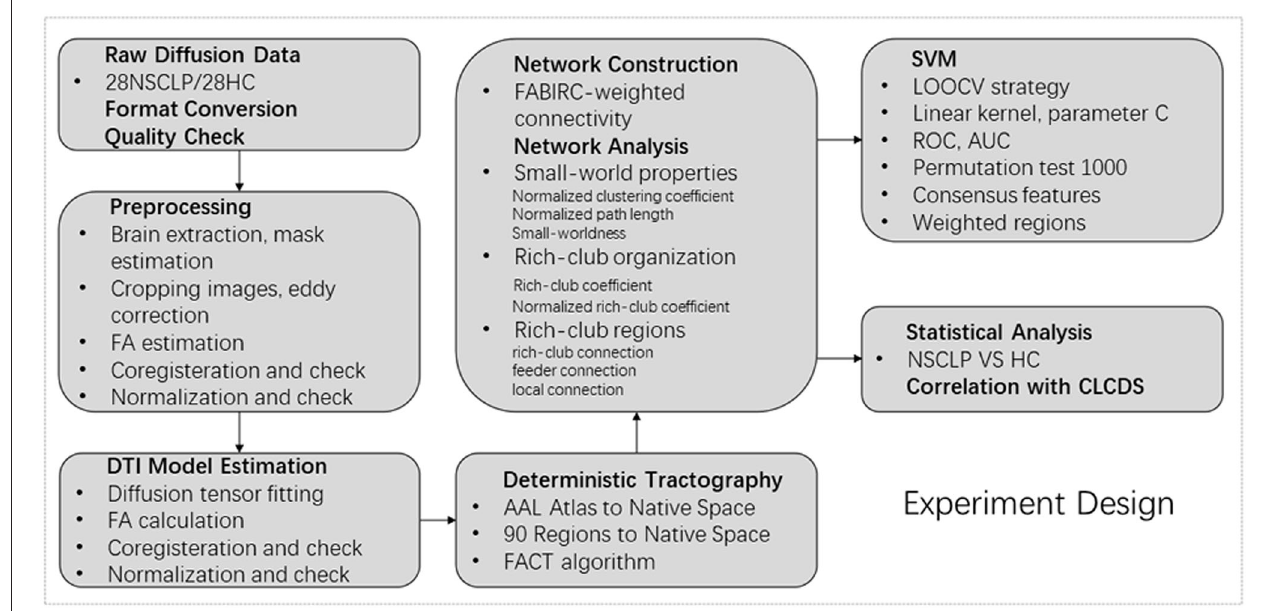
FIGURE 1 | Flowchart of experiment design.